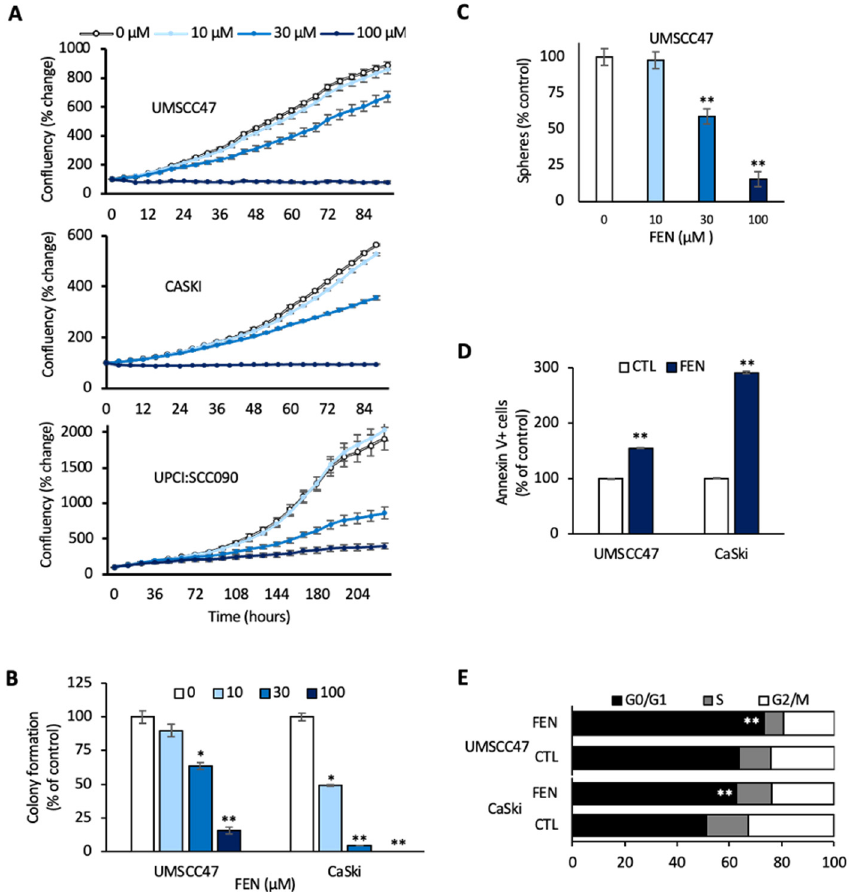
Figure 5. Fenofibrate induces a global anti-cancer effect. ( A ) Cell proliferation. UMSCC47, UPCI:SCC090, and CaSki cell lines were treated with control or fenofibrate. Cell proliferation was measured using the IncuCyte live cell imaging system. Data are represented as mean ± SEM. ( B ) Colony formation assay. Colony counts are shown as a percentage of control for the indicated doses of fenofibrate. * p < 0.05; ** p < 0.01. ( C ) Tumorsphere formation assay. Tumorsphere counts are shown as a percentage of control for the indicated doses of fenofibrate. ** p < 0.01. ( D ) Apoptosis assay. Percentage of Annexin V+ cells following control or fenofibrate treatment, ** p < 0.01. ( E ) Cell cycle analysis. Black, gray, and white bars indicate the percentage of the total population in each cell cycle phase in response to control or fenofibrate treatment, ** p <